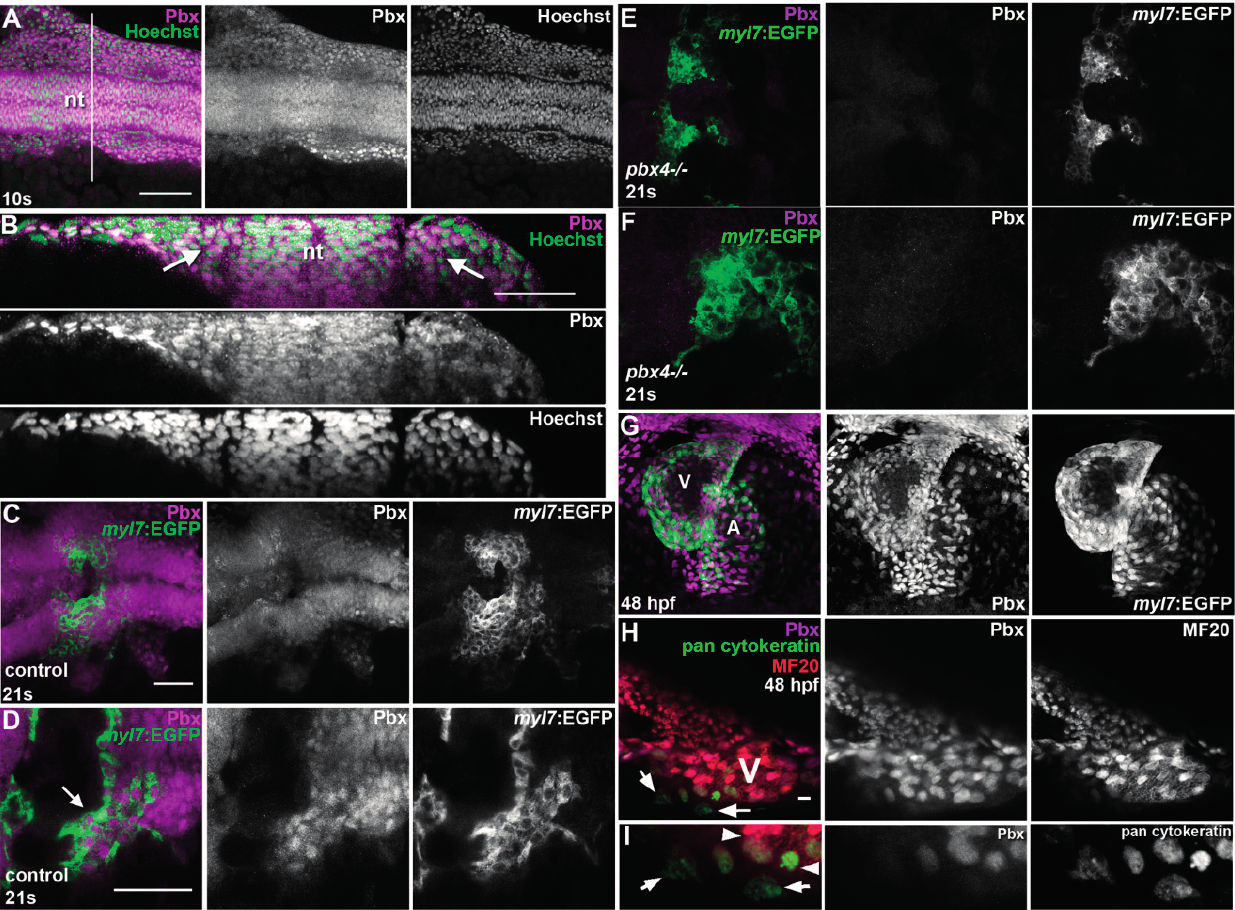
Figure 5. Analysis of Pbx expression during zebrafish cardiac development. ( A – G ) Pbx immunostaining at ( A – B ) 10 s (14 hpf), ( C – F ) 21 s (19.5 hpf), and ( G – H ) 48 hpf. ( A – B ) Pbx expression (magenta) in wild type 10 s embryo co-stained with Hoechst to label nuclei (green). ( A ) Dorsal view, anterior to the left. The line in ( A ), approximately at the level of hindbrain rhombomere 3, shows where we took an optical cross-section view for ( B ). Arrows in ( B) show Pbx expression in ALPM cells next to the neural tube (nt in A , B ). ( C–F ) Pbx expression (magenta) in Tg(myl7:EGFP) twu34 (green) 21 s ( C – D ) control embryo and ( E – F ) pbx4-/- embryo, at low ( C , E ) and high ( D , F ) magnification. Arrow in ( D ) points to cells co-expressing myl7 :EGFP and Pbx. Dorsal view, anterior to the left. ( G ) Pbx expression (magenta) in Tg(myl7:EGFP) twu34 (green) 48 hpf embryo. Ventral view, anterior to the top. V, ventricle. A, atrium. ( H – I ) Pbx expression (magenta) in wild-type 48 hpf embryo co-stained for proepicardial pan-cytokeratin expression (green) and myocardial cells (MF20, red), at low ( H ) and high ( I ) magnification. V, ventricle. Arrows in ( H , I ) point to two pan-cytokeratin-expressing cells that do not express Pbx, compared to neighboring cardiomyocytes and pan-cytokeratin/Pbx co-expressing cells (arrowheads, I ). Scale bar for ( A ): 100 µm. Scale bar for ( B – D ): 50 µm. Scale bar for ( H ): 10 µm.